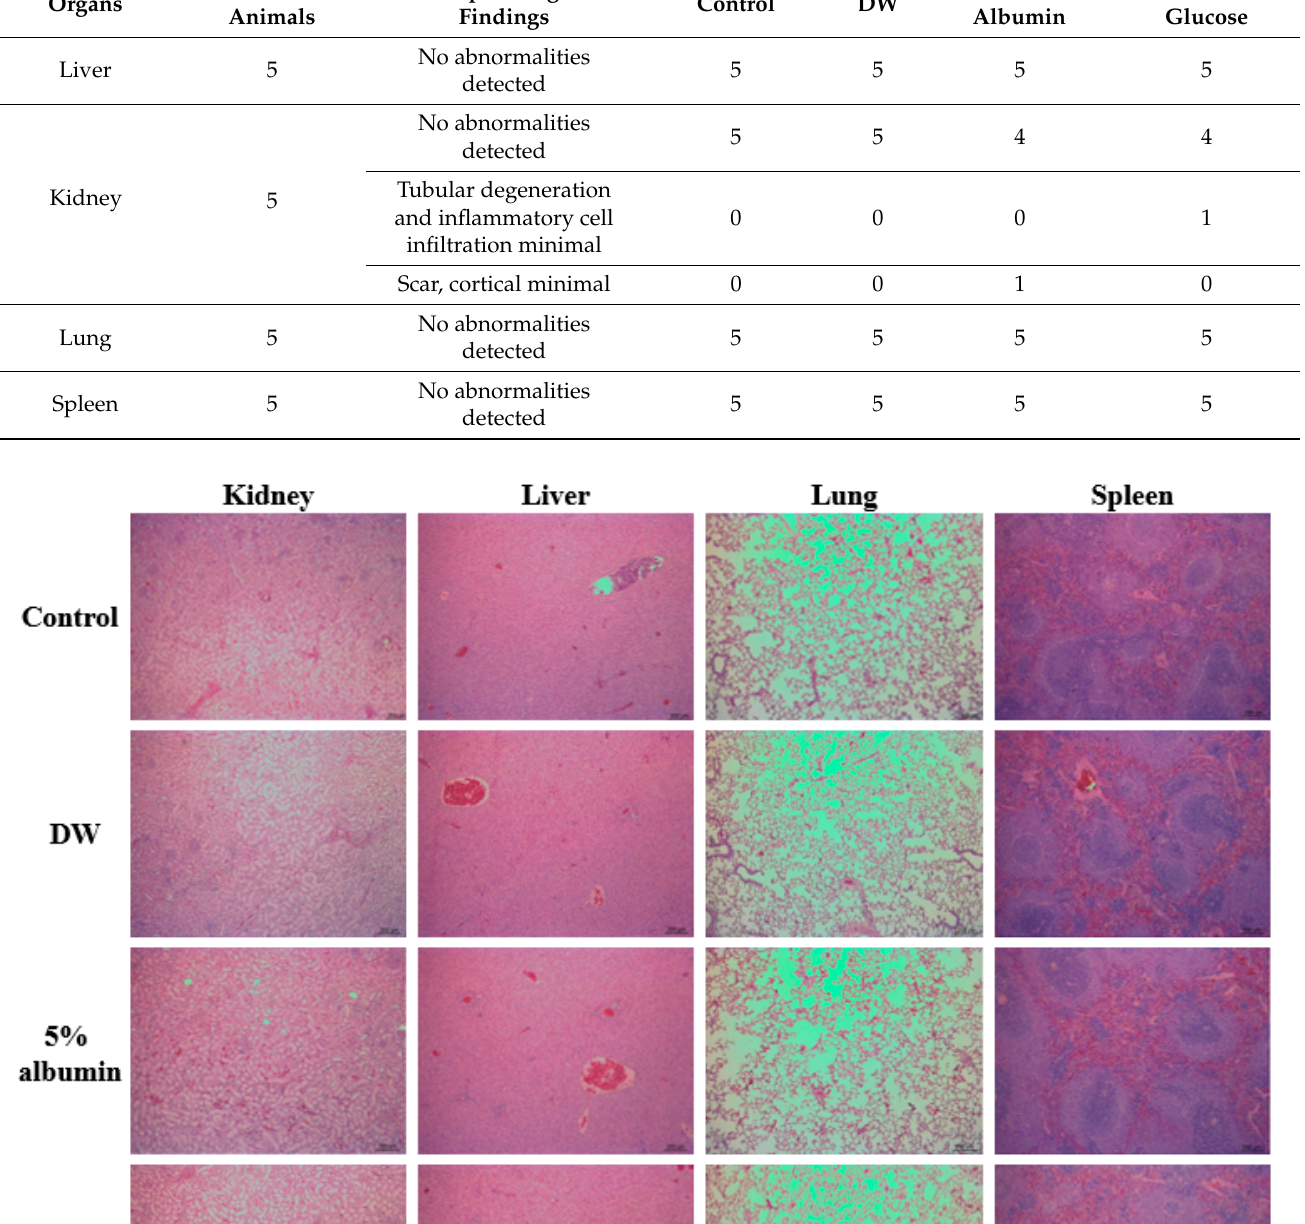
Table 5. Summary of histopathological findings of rats after oral administration of ZnO NPs (100 mg/kg) interacted with DW, albumin, or glucose for 14 consecutive days.